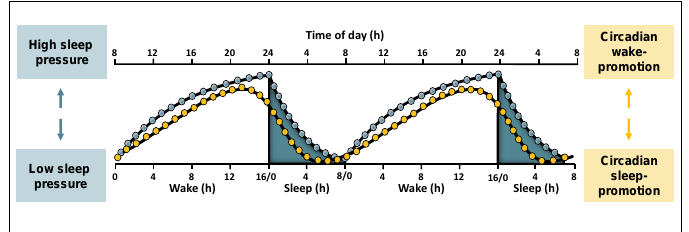
Figure 1. Illustration of human sleep-wake regulation by circadian and homeostatic mechanisms under entrained conditions. Under entrained conditions wakefulness is scheduled to daytime, and sleep to the biological night. The homeostatic sleep need ( blue ) increases during wakefulness and declines during sleep. Circadian oscillations ( yellow ) promote wakefulness during the day and sleep during the night, and are relatively independent of prior sleep-wake history. Figure and legend adapted from a previous publication [40]. Reproduced with permission.